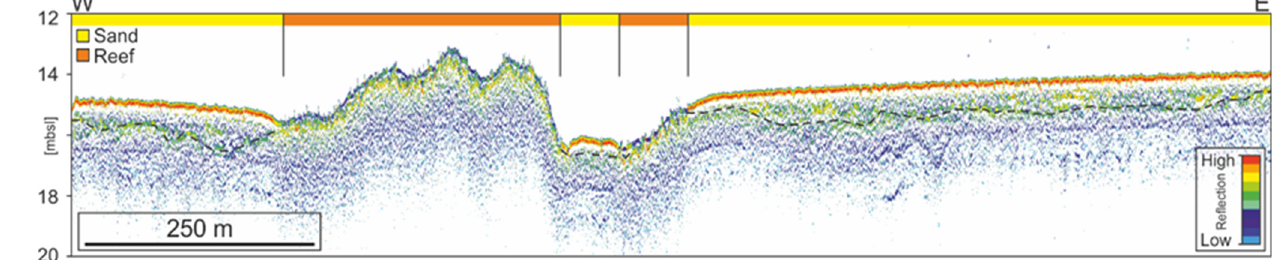
Figure 5. Sub-bottom profiler track across the study area (Location in Figure 1). The thickness of the mobile sand layer on top of the morainal material (indicated by the dashed line) in the area rarely exceeds 2 m.